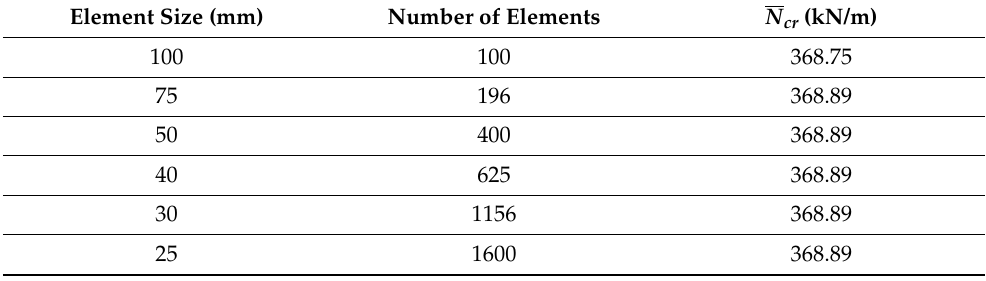
Table 1. Mesh convergence test for the verification of the computational model by Piscopo [23].